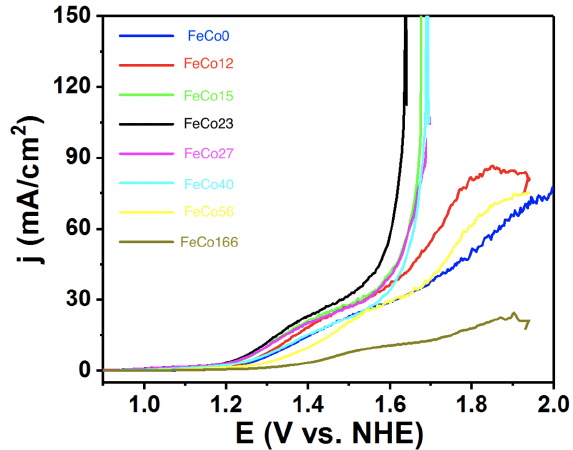
Figure 1. Linear sweep voltammetry recorded (1 mV/s) for the FeCo Z electrodes. Electrolyte: 0.1 M KPi + 1 M KNO 3 , pH =